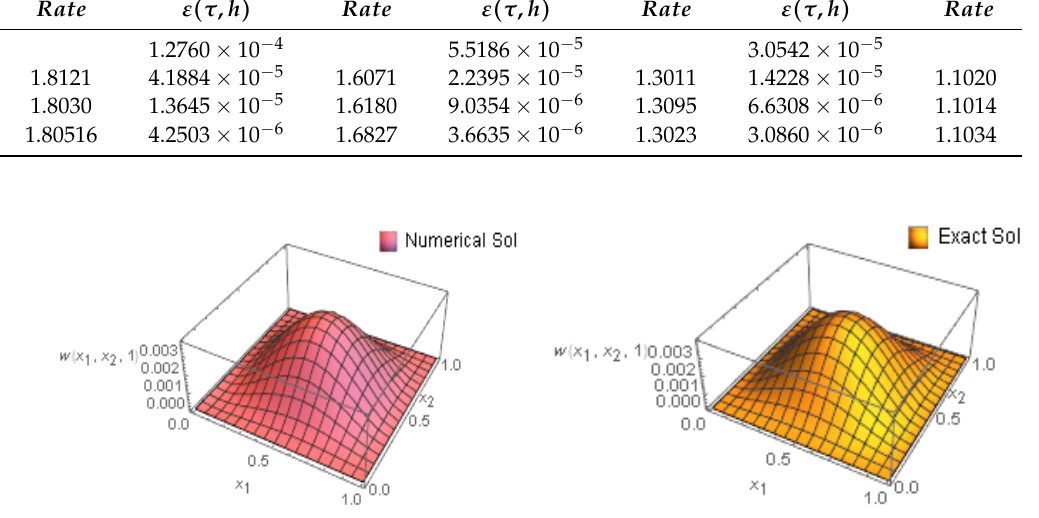
Figure 1. Exact and Numerical scheme solution of (21) at α = 0.7, β = 0.8, τ = 0.05, h = 0.1 and t = T = 1.